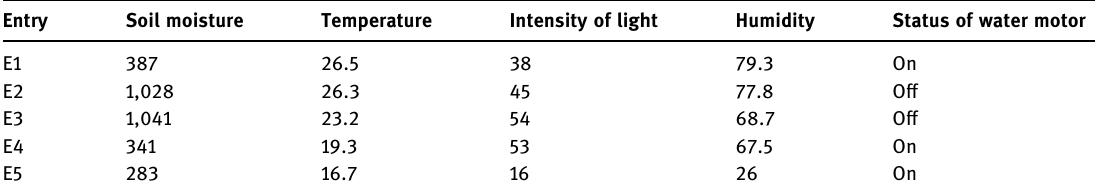
Table 7: Controlling actuator response through sensed data Entry Soil moisture